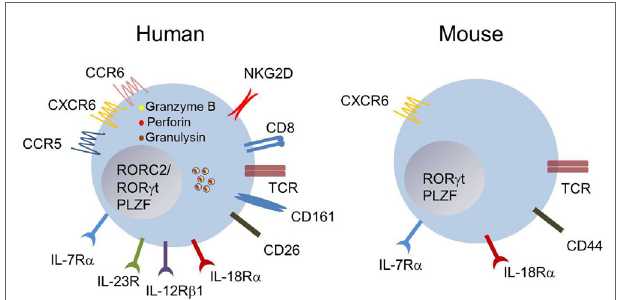
FiGURe 1 | Phenotype of human and mouse MAiT cells . Blood MAIT cells in humans are defined as TCRV α 7.2 + CD161 hi -expressing T cells. Most MAIT cells are CD8 + , and express an effector/memory phenotype CD45RO + CD62L lo CCR7 − (not depicted). They express several chemokine- and interleukin-receptors at steady state. They are equipped with the cytotoxicity co-receptor NKG2D, and display intra-cytoplasmic granules containing granulysin, granzyme B, and perforin. The expression of CD161, IL-18R α , or CD26 at high levels is usually sufficient to identify MAIT cells within the CD8 + subset in human blood. The phenotype of mouse MAIT cells is apparently more diverse, and dependent upon the tissues examined. Most of them are CD4 − CD8 − (double negative), display an effector/memory phenotype and the interleukin and chemokine receptors IL-7R α , IL-18R α , and CXCR6 (16, 17, 23, 24,